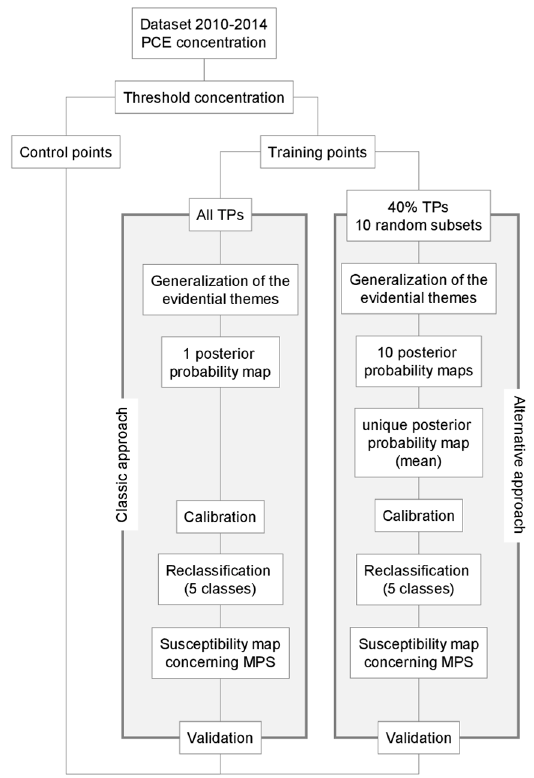
Figure 2. Flow chart representing the classic and the alternative Weights of Evidence (WofE) procedures.